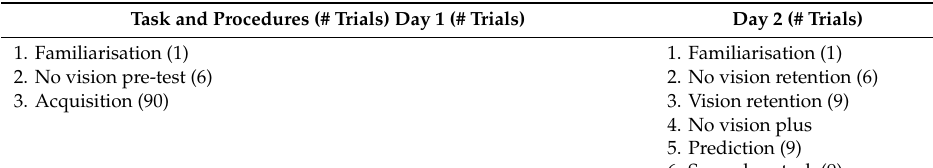
Table 1. Summary of procedures and dependent measures. IMI: Intrinsic Motivation Inventory, SMS: Situational Motivation